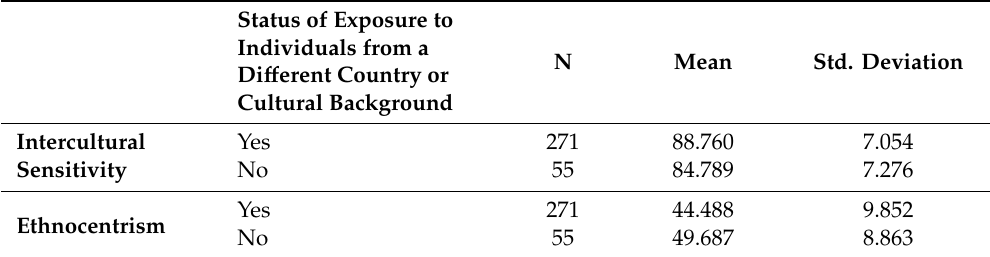
Table 17. Mean and standard deviation of the scores of the students in the Intercultural Sensitivity Scale and the Ethnocentrism Scale by their exposure to individuals from a di ff erent country or cultural background.